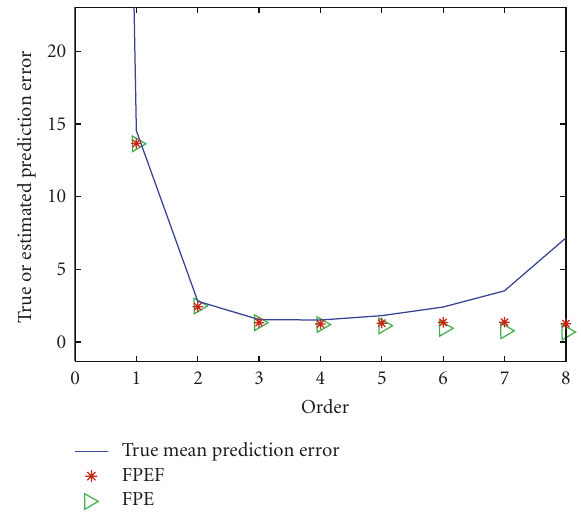
Figure 5: Estimation of prediction error for simulated AR(7) sequence with N =